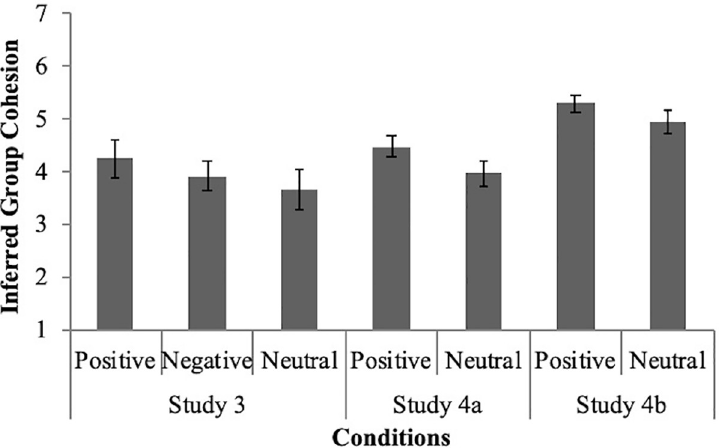
Fig 6. Inferred group cohesiveness as a function of the relationship between prototypicality and intragroup respect.